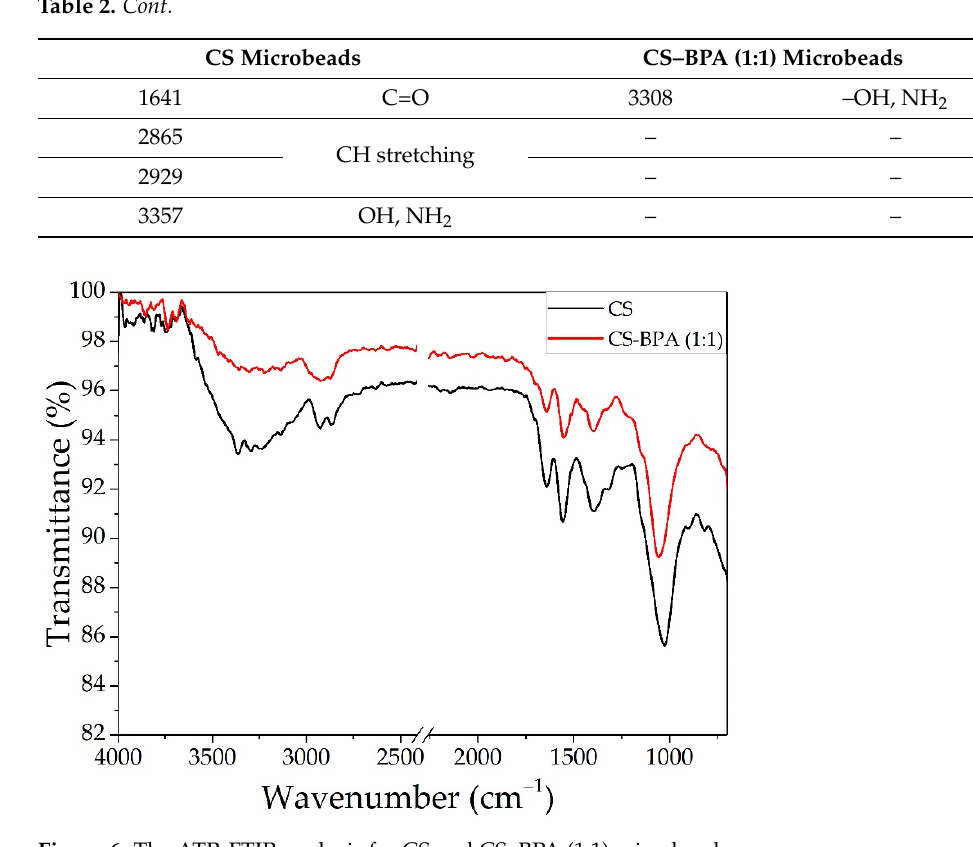
Figure 6. The ATR-FTIR analysis for CS and CS–BPA (1:1) microbeads. Table 2. Peak data for CS and CS–BPA (1:1) microbeads.